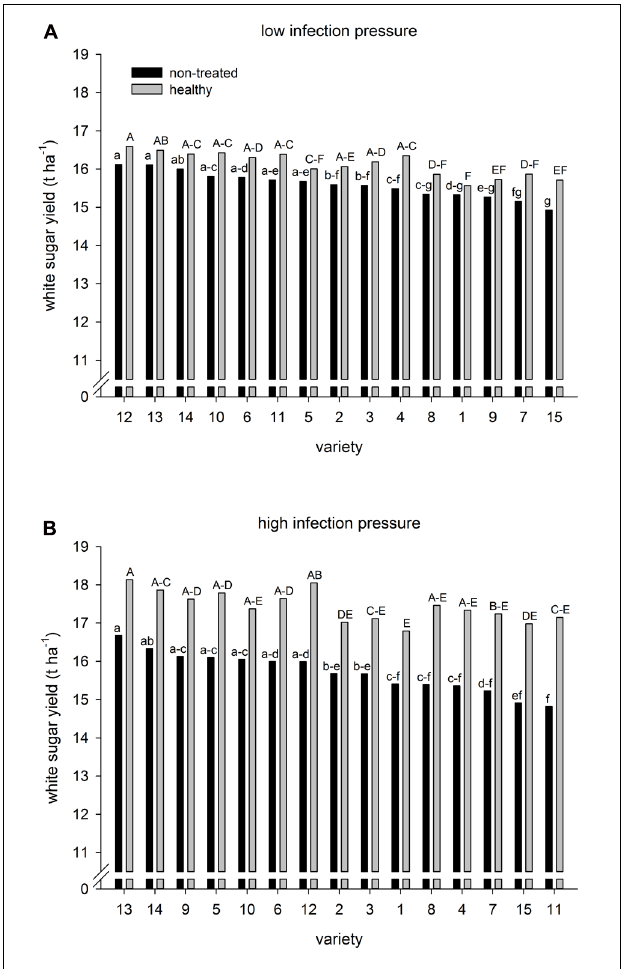
FIGURE 1 | White sugar yield of sugar beet varieties at environments with (A) low and (B) high infection with Cercospora beticola at two fungicide levels (non-treated and healthy). 30 and 15 environments in Germany, 2014–2016. Different lower case letters indicate significant differences in the non-treated level; different upper case letters indicate significant difference in the healthy level (Tukey-Test, P ≤ 0.05).